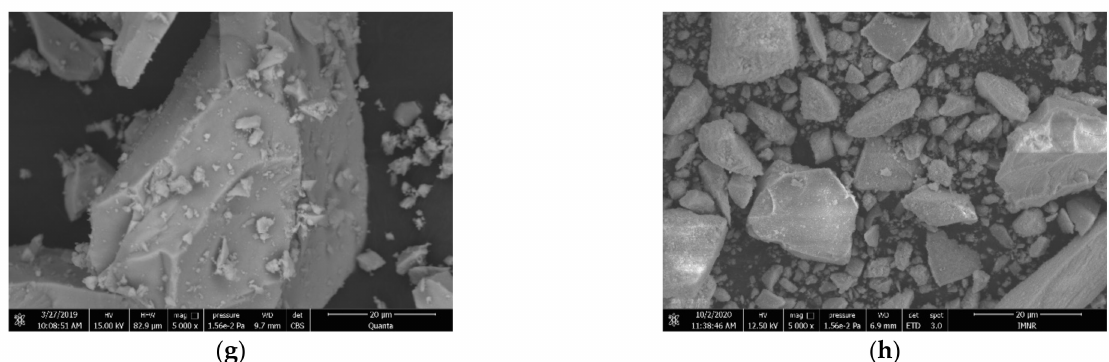
Figure 4. SEM images for 6% MxZYLn powders as obtained and calcined at 1000 ◦ C. ( a ) MxZY-6La initial powders; ( b ) MxZY-6La calcined 1000 ◦ C powders; ( c ) MxZY-6Nd initial powders; ( d ) MxZY-6Nd calcined 1000 ◦ C powders; ( e ) MxZY-6Sm initial powders; ( f ) MxZY-6Sm calcined 1000 ◦ C powders; ( g ) MxZY-6Gd initial powders; and ( h ) MxZY-6Gd calcined 1000 ◦ C powders. Table 3. Grain sizes of 4, 6, 8% MxZyLn powders, initial and calcinated at 1000 ◦ C.